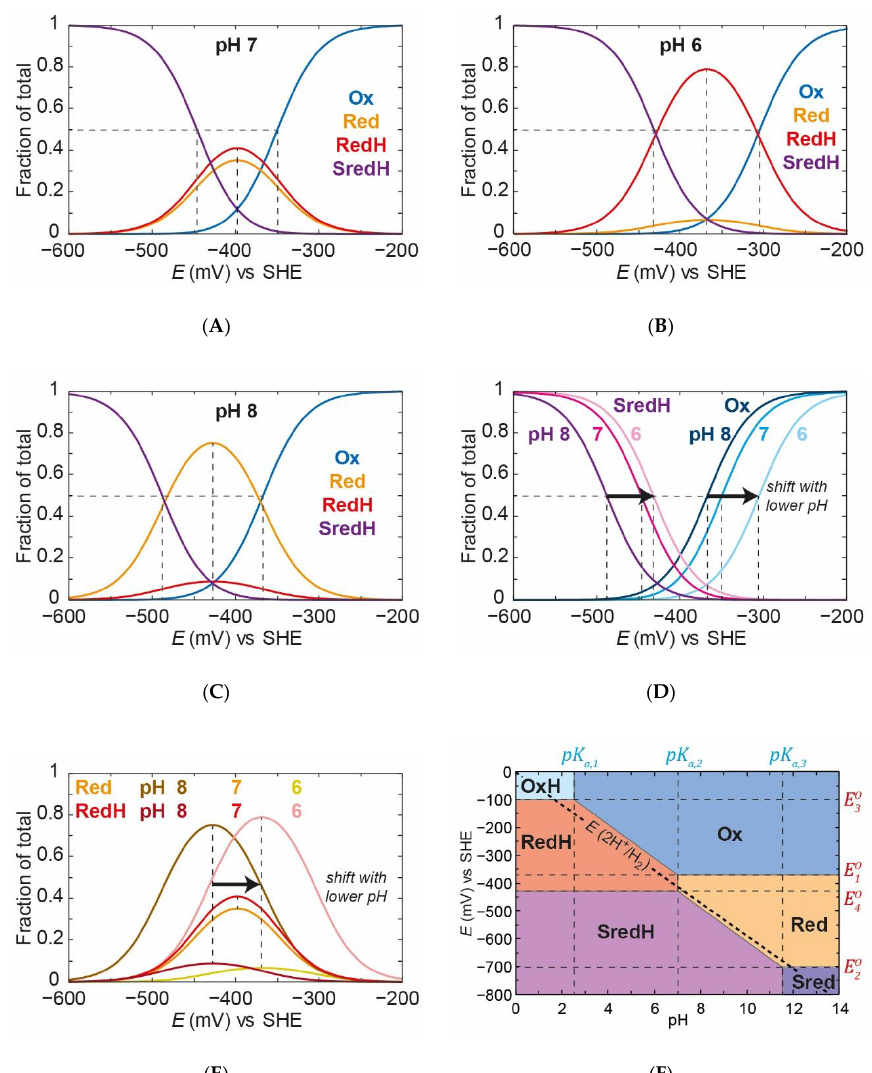
Figure 9. Variation of the fraction (out of 1) of the deprotonated oxidised ( Ox , blue), deprotonated reduced ( Red , orange), protonated reduced ( RedH , red), and protonated super-reduced ( Sred H, purple) species as a function of the applied po- tential at pH 7 ( A ), pH 6 ( B ), and pH 8 ( C ). The curves were obtained using Equations (22)–(26) with 𝐸 1𝑂 = −370 mV, 𝐸 2𝑂 = −700 mV, 𝐸 3𝑂 = −100 mV, and 𝐸 4𝑂 = −430 mV, giving an average E O of −400 mV. For a comparison with previous figures, and K a, 1 = 3.16 × 10 −3 ( pK a, 1 = 2.5). K a, 2 was calculated using Equation (27) to be 8.58 × 10 −8 ( pK a, 2 = 7.1) and K a, 3 was calculated using Equation (28) to be 2.33 × 10 −12 ( pK a, 3 = 11.6). OxH and Sred are not shown because their concentrations are effectively zero at each pH. ( D ) Ox (blue) and SredH (purple) are plotted at pH 6 (light), pH 7 (medium), and pH 8 (dark). ( E ) Red (orange) and RedH (red) are plotted at pH 6 (light), pH 7 (medium), and pH 8 (dark). ( F ) The Pourbaix diagram showing the regions with respect to pH and applied potential ( E ) where Ox (dark blue), OxH (light blue), Red (orange), RedH (red), Sred (dark purple), and SredH (light purple) dominate, based on the values of 𝐸 1𝑂 to 𝐸 4𝑂 and pK a, 1 to pK a, 3 described above. The thermodynamic potential of the 2H + /H 2 couple is plotted vs. pH (dotted line) for a comparison.